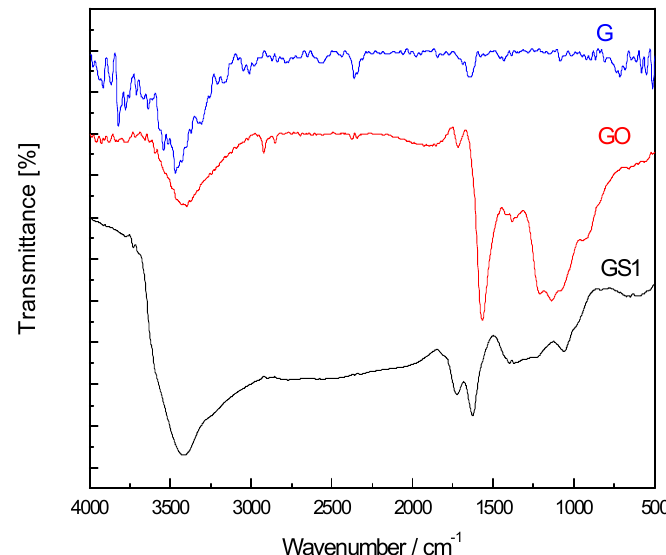
Figure 5. Fourier transform infrared (FT-IR) spectra for graphite, graphite oxide, and graphene.